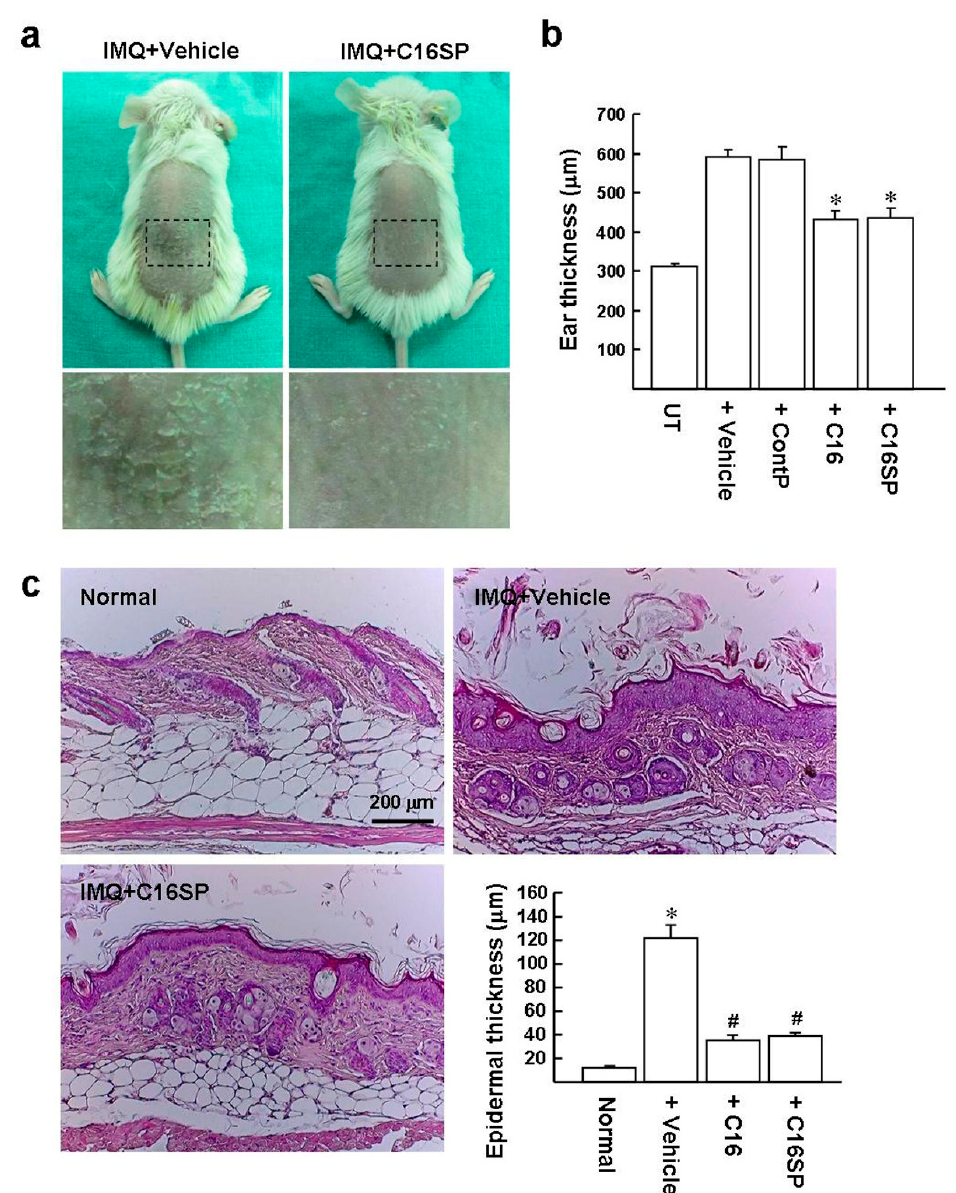
Figure 4. C16 and C16SP improve the symptoms of IMQ-induced psoriasis. BALB / c mice (eight-week-old) received a daily topical treatment with IMQ cream on the shaved back and right ear for six consecutive days. ( a ) Physical appearance of the back skin at the end of the study. Insert: Back skins photographed at higher magnification with a light-field camera. ( b ) Ear thickness measured by digital micrometer. * p < 0.001 versus IMQ / vehicle-treated group. ( c ) Histopathological examination of H&E stained dorsal skin. Representative images from three independent experiments with six mice per group are shown. The measurement of epidermal thickness is described in the Methods. Results are expressed as mean ± SD. * p < 0.0001 versus normal control group. # p < 0.0005 versus IMQ / vehicle treatment.